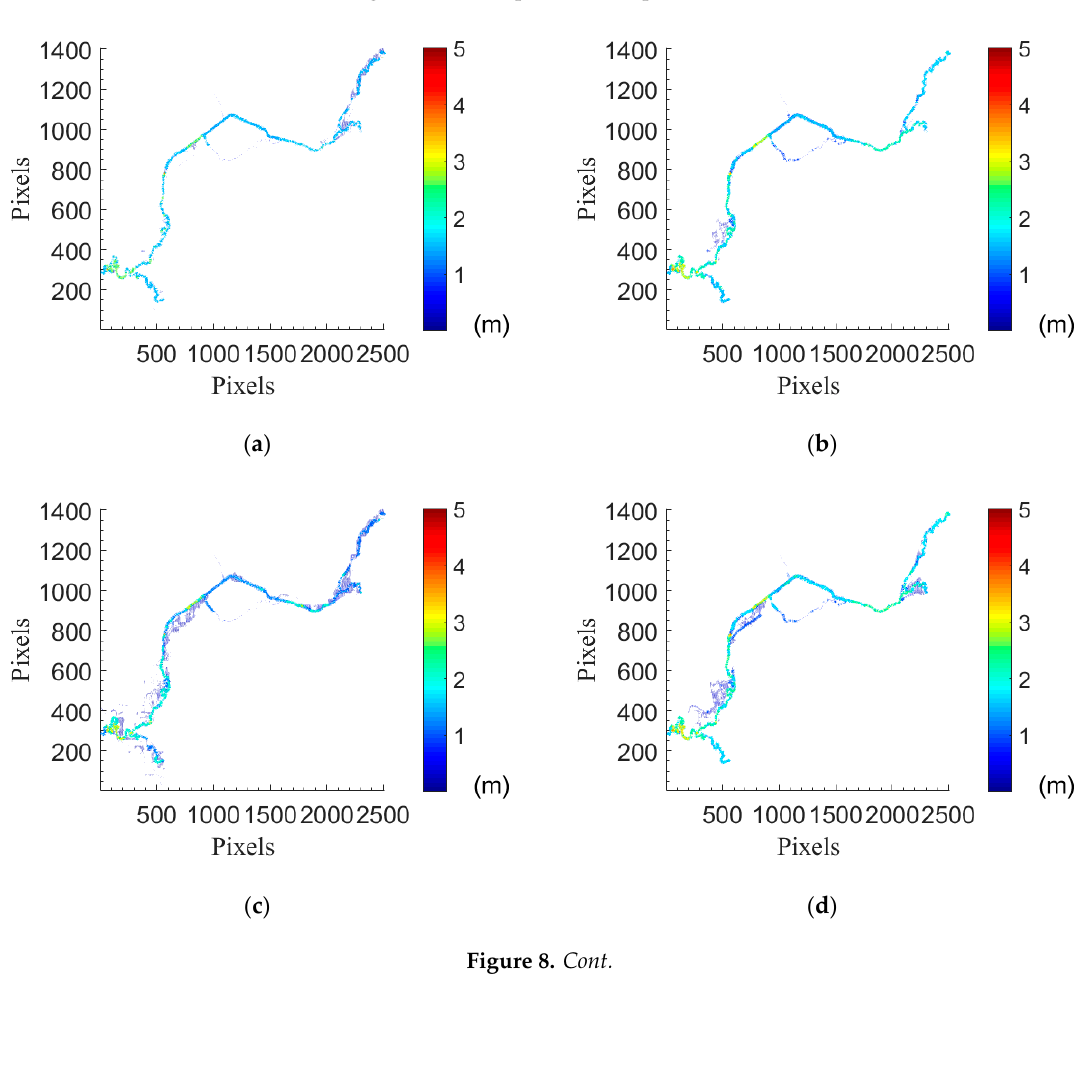
Figure 7. Hydrographs of the flood event in 2013. Seven discharge curves of three rivers and four streams are shown in different colors. The red line time marks the new start of the prediction at 9 h, where one discharge first exceeds the forecast threshold of 10 m 3 /s. The dash lines upon the discharge curves mark the different discharge sections for prediction inputs.